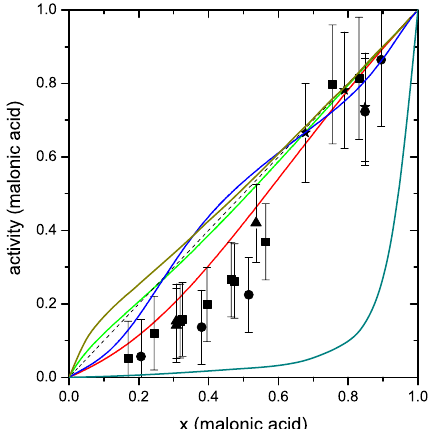
Fig. 6. Malonic acid activity versus mole fraction: Data at T = 273 . 8K: F , T = 281 . 0K: , T = 291 . 0K: (cid:4) , T = 300 . 0K: N . Data from Zardini et al. (2006). Dotted line: Raoult’s law; Dark yellow line: UNIFAC Dortmund parameterization taken from Ko- ponen et al. (2007); Dark cyan line: van Laar parmeterization by Koponen et al. (2007); Green line: UNIFAC parameterization by Ming and Russell (2002); Blue line: parameterization by Clegg and Seinfeld (2006a) ∗ ; Red line: UNIFAC parameterization by Peng et al. (2001). Mole fractions are on the basis of undissociated malonic acid. ∗ See footnote to Fig. 2.